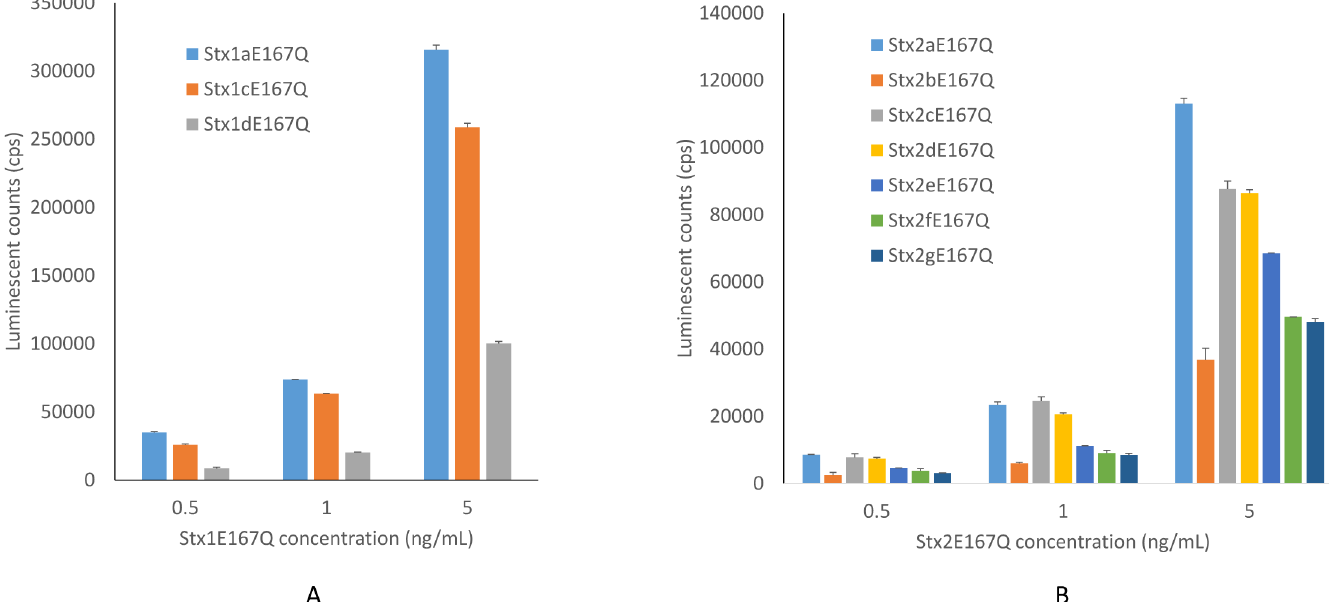
Fig 3. Detection of subtypes of Stx1 and Stx2 toxoids using the universal sandwich ELISA. A mixture of mAbs including mAbs Stx1-2, Stx2-5, Stx2b-1, Stx2e-2, and Stx2f-1 was used for capture (1 μ g/mL each) and a mixture of Stx1 and Stx2 pAbs was used for detection (100 ng/mL each), the goat anti-rabbit IgG-HRP was used as a secondary antibody (10 ng/mL). The data shown represent the mean plus SD of three replicates from one representative experiment. Three individual experiments were performed.